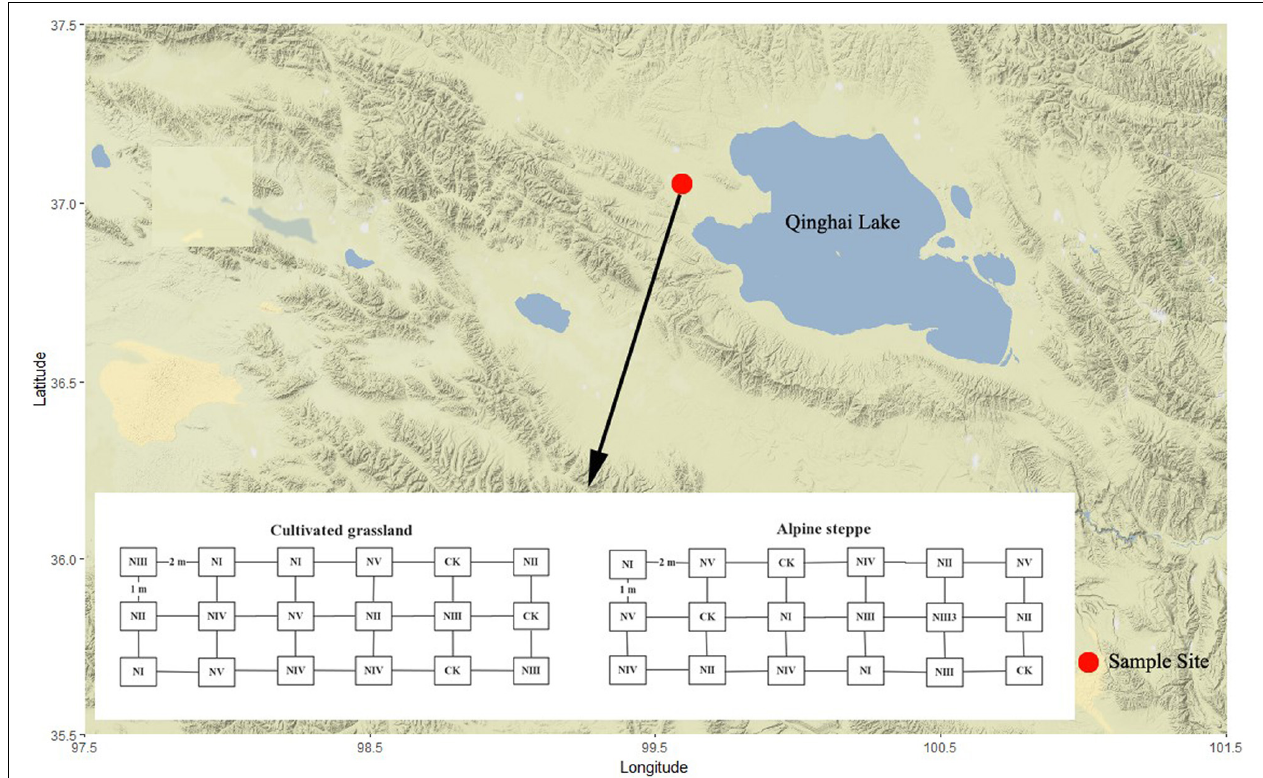
FIGURE 1 | Geographical location of the study site on the terrain-background map. CK, no N addition, NI, addition at 8 kg N/ha/year, NII, addition at 24 kg N/ha/year, NIII, addition at 40 kg N/ha/year, NIV, addition at 56 kg N/ha/year, and NV, addition at 72 kg